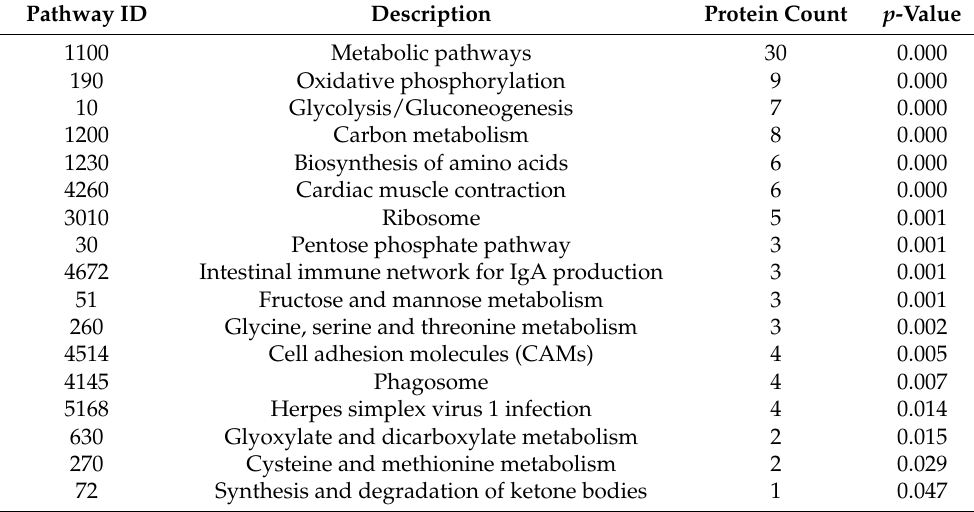
Table 5. KEGG pathways enrichment analysis of differentially expressed proteins that were associated with V. alginolyticus experimental infection.